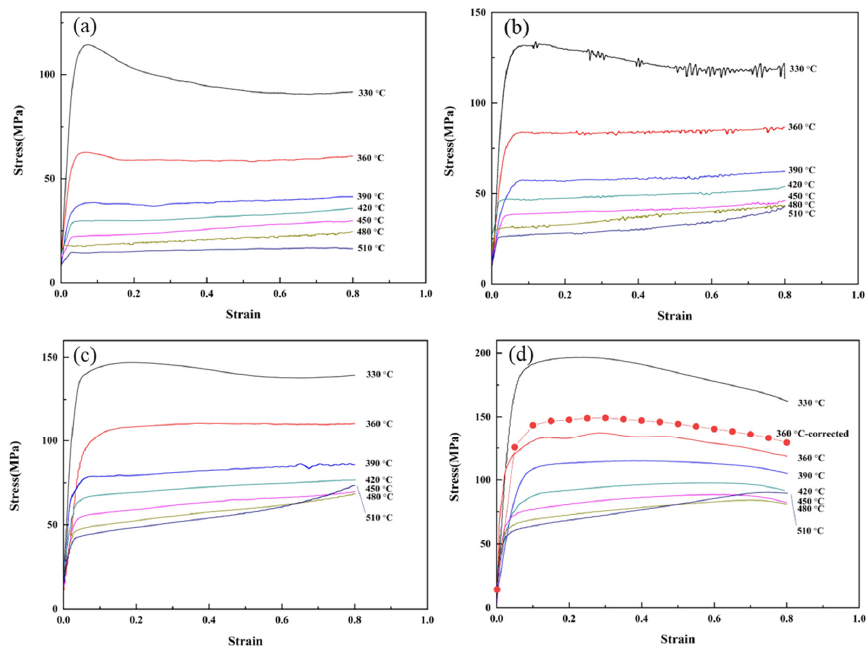
. ε = . ε = 0.01 s − 1 , ( b ) 0.1 s − 1 ,